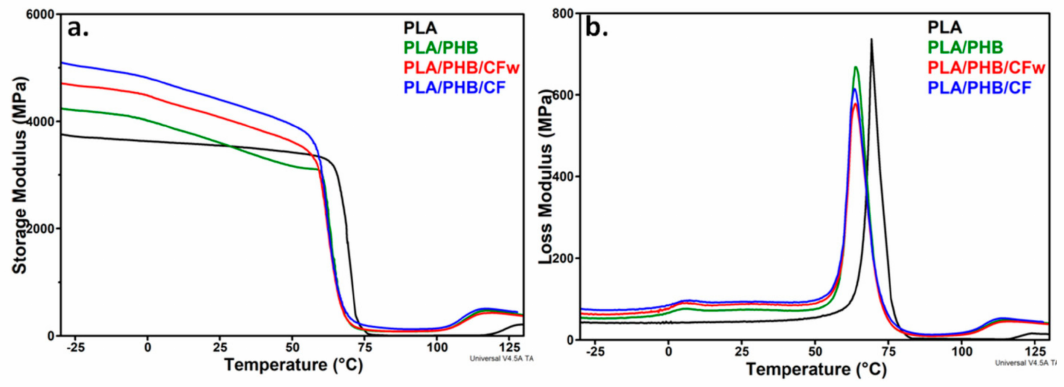
Figure 7. Storage modulus ( a ) and loss modulus ( b ) of PLA, PLA/PHB and biocomposites against temperature.